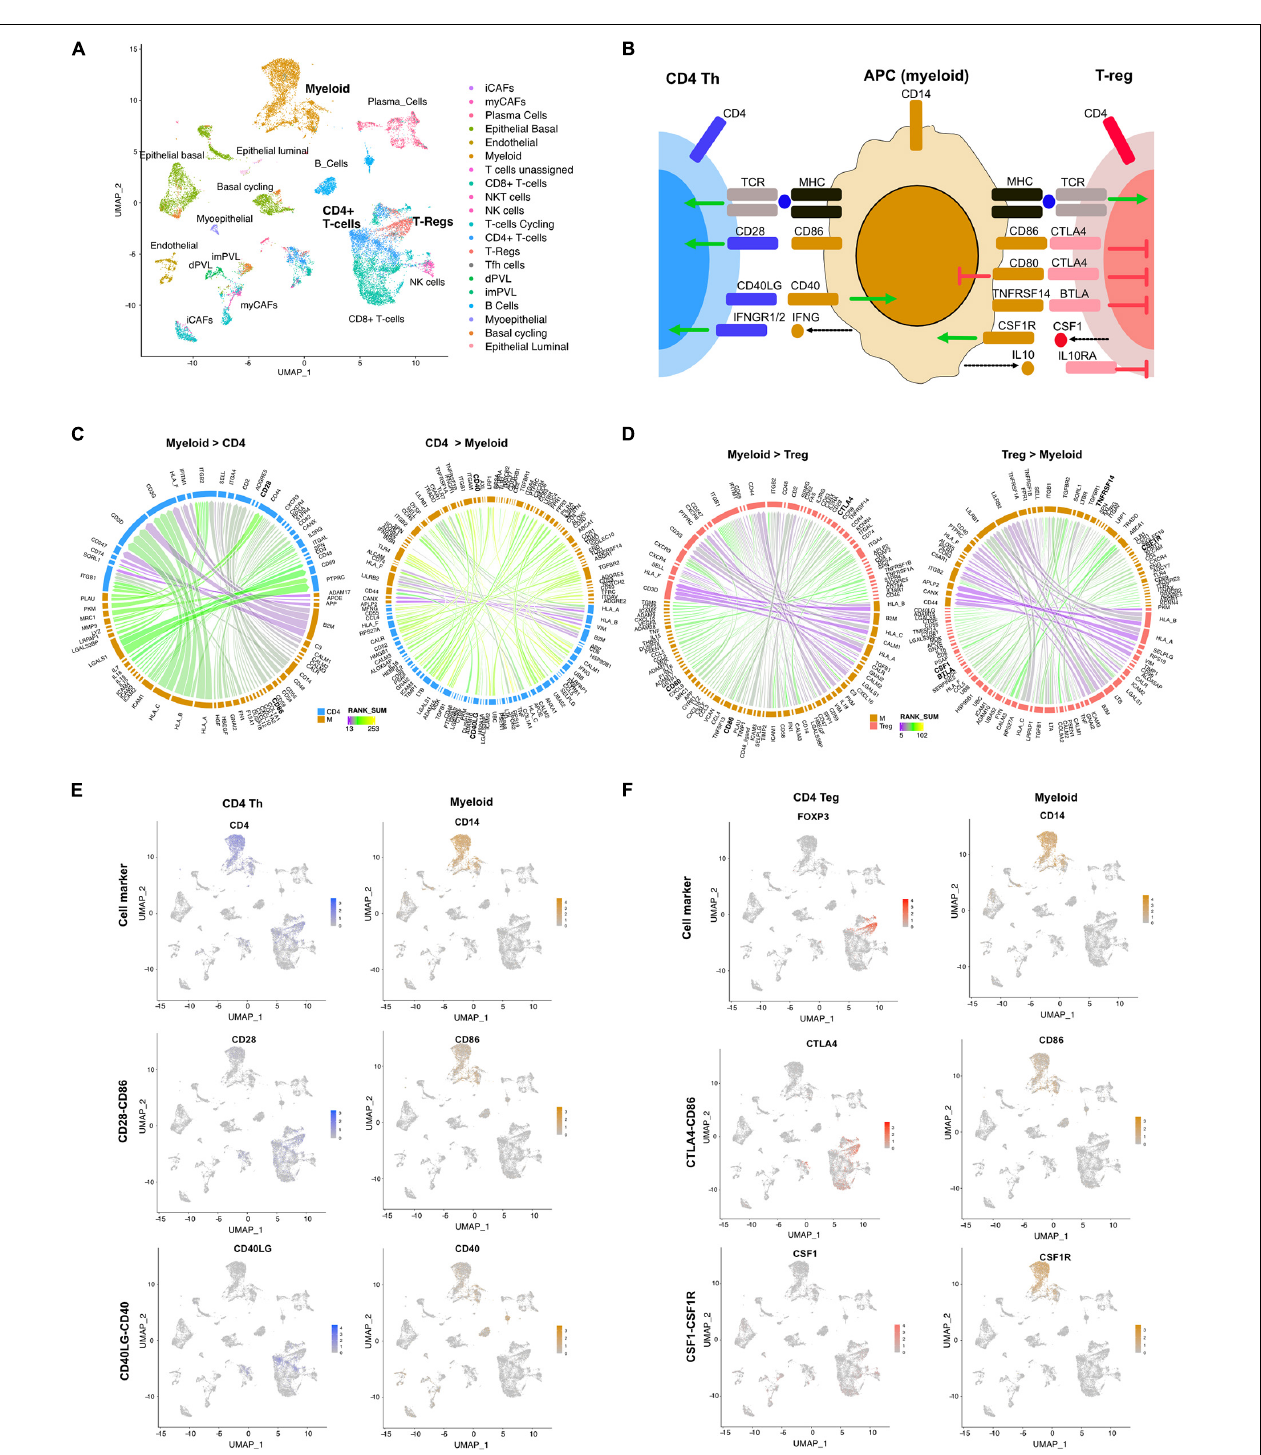
FIGURE 2 | Differential LR interactions between myeloid cells and either Th or Treg cells. (A) UMAP plot shows distinct cell populations in five TNBC tumors. (B) Image shows known interactions identified by LR hunting between myeloid antigen presenting cells and either CD4 Th or Tregs. Colored arrows indicate direction of signaling from ligand to receptor for stimulatory (green) and inhibitory (red) events. Dashed arrows indicated secreted ligands. Circos plots show the top interactions and by direction for (C) myeloid and CD4 T cells and (D) myeloid and Treg cells. LR interactions are colored by interaction strength (rank sum) and line thickness represents the frequency of interaction across the five tumors. (E) UMAP plots show expression of CD4 Th and myeloid cell markers and expression of LR interactions for CD28-CD86 and CD40L-CD40. (F) UMAP plots show expression of Treg and myeloid cell markers and expression of LR interactions for CTLA4-CD86 and